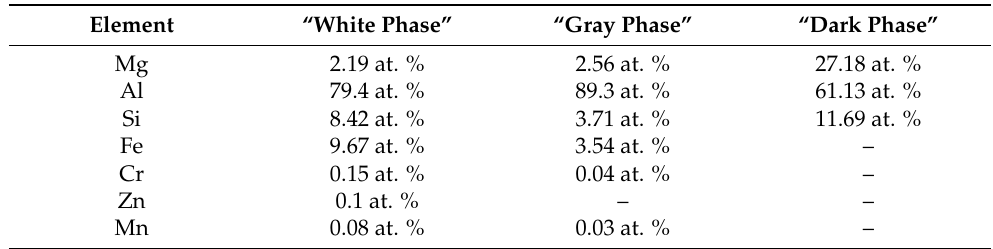
Table 1. The average composition, in atomic percent, was assessed for each of the phases associated with Figure 4.